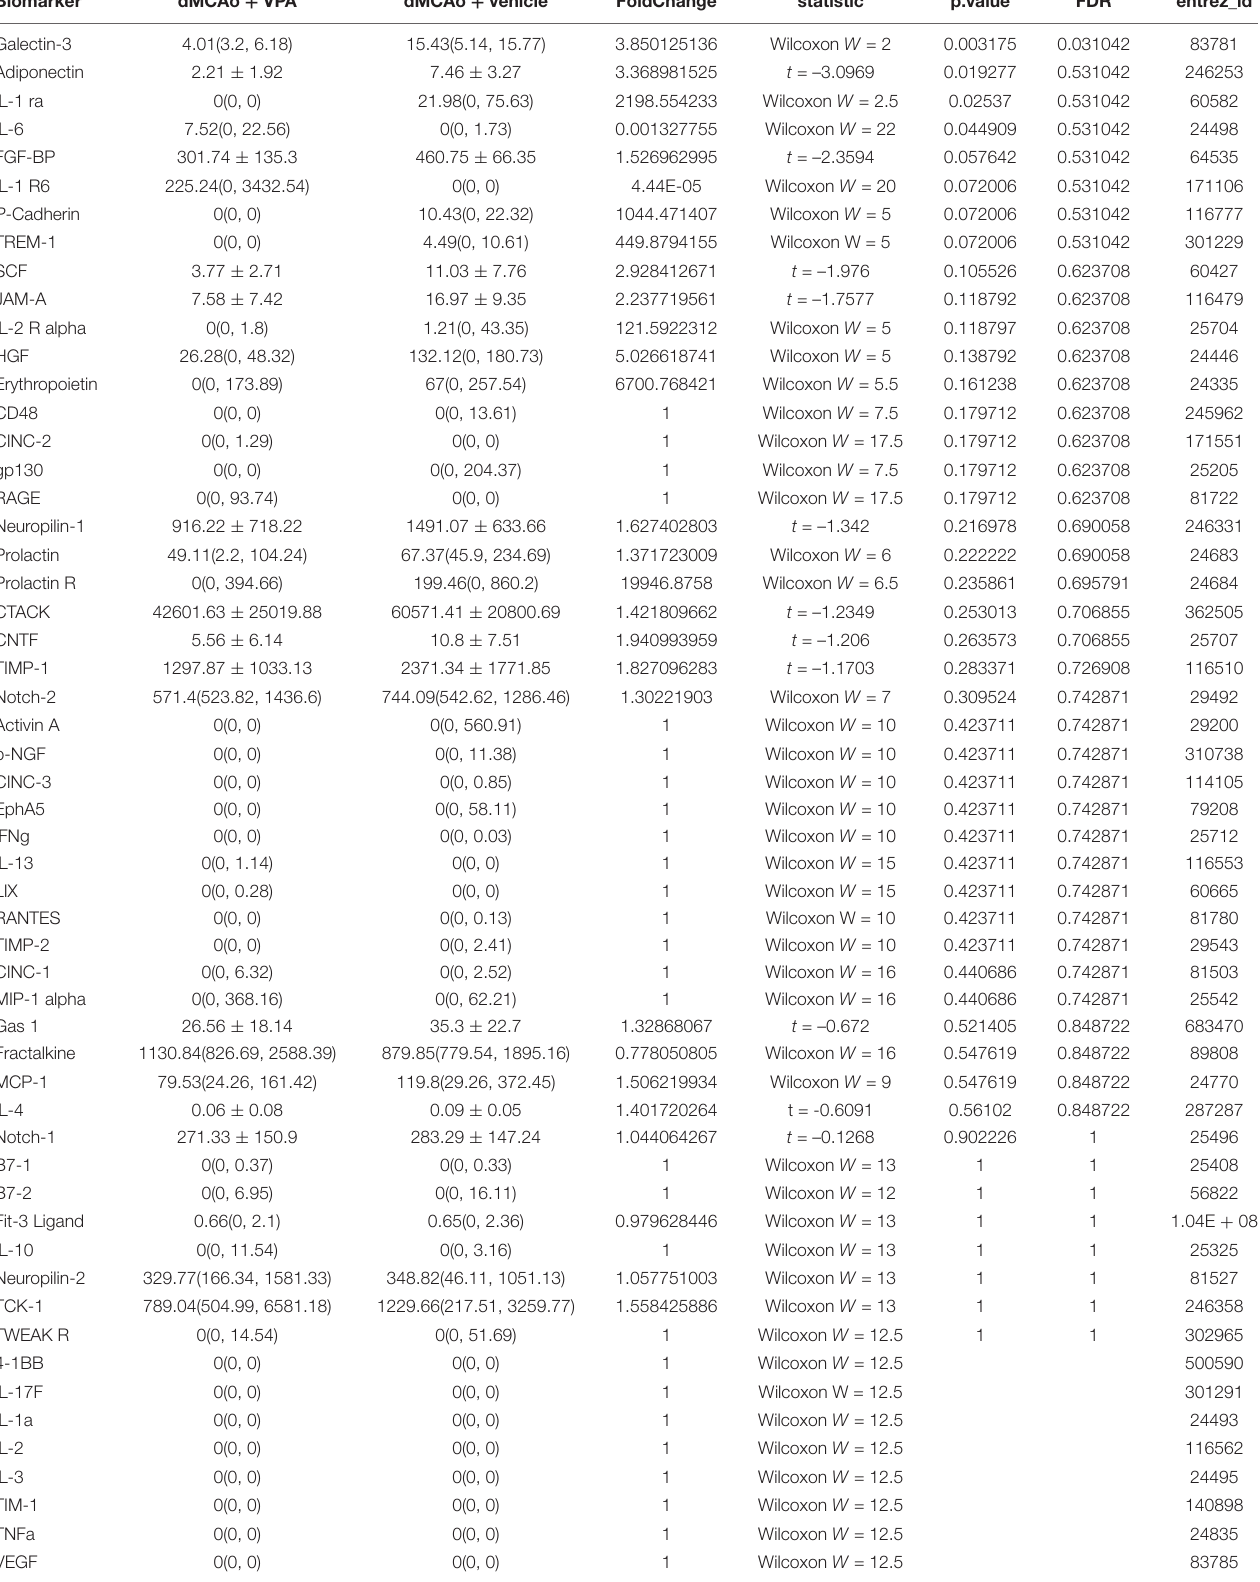
TABLE 3 | Comparison on 67 biomarkers between dMCAo + vehicle and dMCAo + VPA